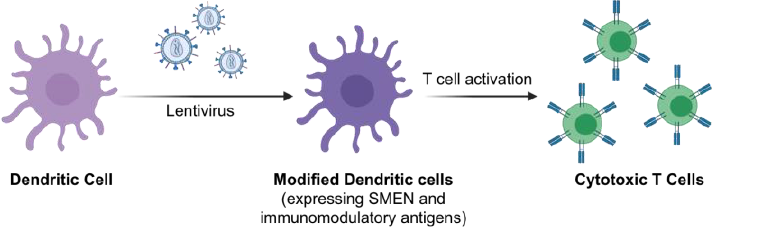
Figure 4. Vaccine candidates currently in clinical trials for COVID-19. ( i ) mRNA 1273 is a mRNA-based vaccine, which encodes the full-length S protein of SARS-CoV-2 virus and is delivered via lipid nanoparticles (LNPs). ( ii ) ChAdOx1 nCoV-19 is a chimpanzee adenovirus vector, which expresses the S protein of SARS-CoV-2 virus inside the host cells and activates the immune system. ( iii ) BNT 162 is a mRNA-based vaccine delivered via LNPs with four candidates (BNT162a1, BNT162b1, BNT162b2, BNT162c2), encoding either the S protein or receptor binding domain (RBD) of S1 subunit. ( iv ) Ad5-nCoV COVID-19 is a replication defective adenovirus 5 vector (Ad5) encoding the full-length S protein of SARS-CoV-2 virus. ( v ) COVID-19 aAPC are artificial antigen-presenting cells (aAPC) modified using a lentivirus vector to express fragments of SARS-CoV-2 proteins and immunomodulatory genes. ( vi ) INO 4800 is a plasmid DNA encoding SARS-CoV-2 proteins and delivered via electroporation using the smart device Cellectra® developed by Inovio. ( vii ) Synthetic Minigene Vaccine or LV-SMENP-DC are genetically modified dendritic cells (DCs) via a lentivirus vector to express SARS-CoV-2 minigenes (SMEN) and immunomodulatory genes, administered via subcutaneous injection. Furthermore, T cells activated using the modified dendritic cells are also administered via intravenous infusion.